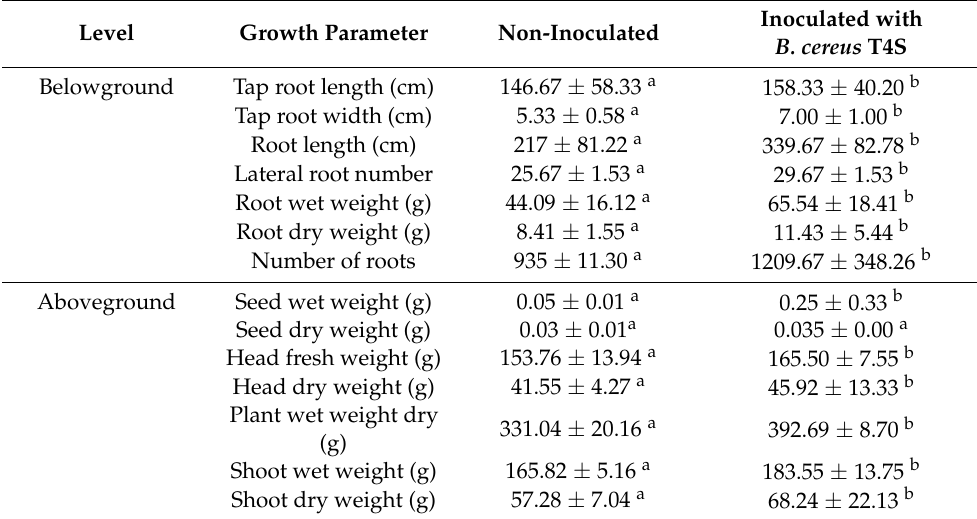
Table 7. Sunflower Yield Parameters.